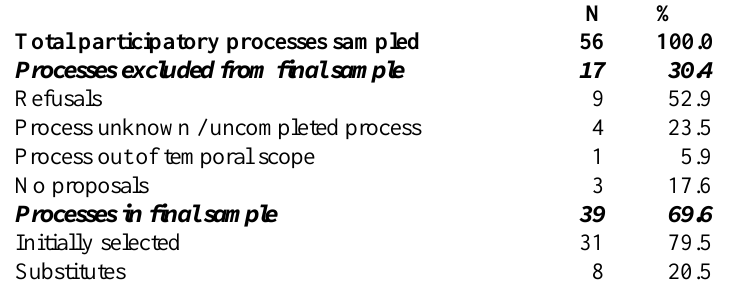
Final sample quality